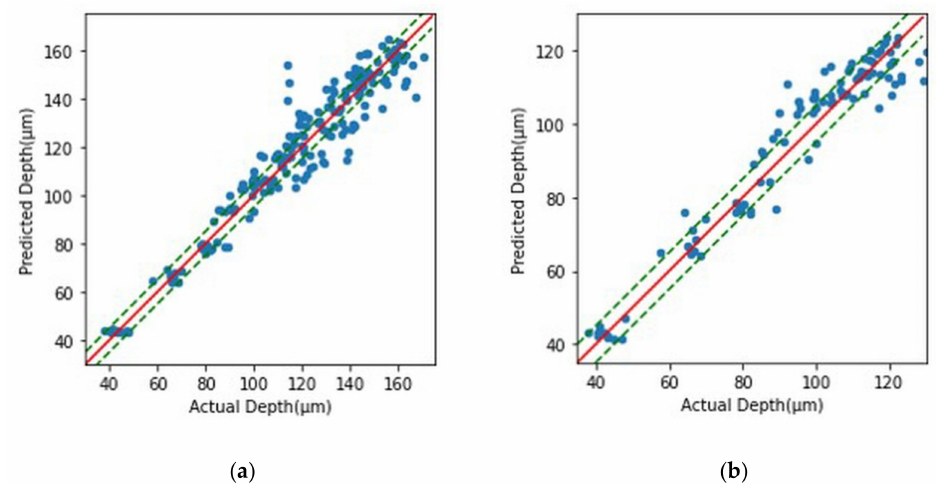
Figure 11. Comparison of actual data and data predicted by the learning model, and the dotted line is the point with a prediction error of ± 5 µ m. ( a ) Comparisons under conditions of 1 to 20 processing times. ( b ) Comparison under conditions of 1 to 10 processing